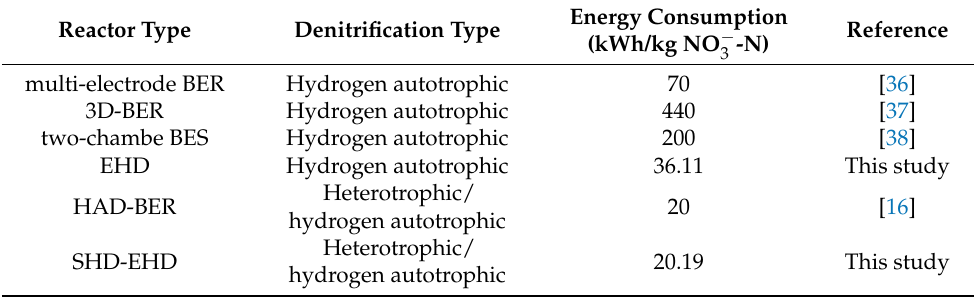
Table 3. Comparison of energy consumption with previous denitrification systems.